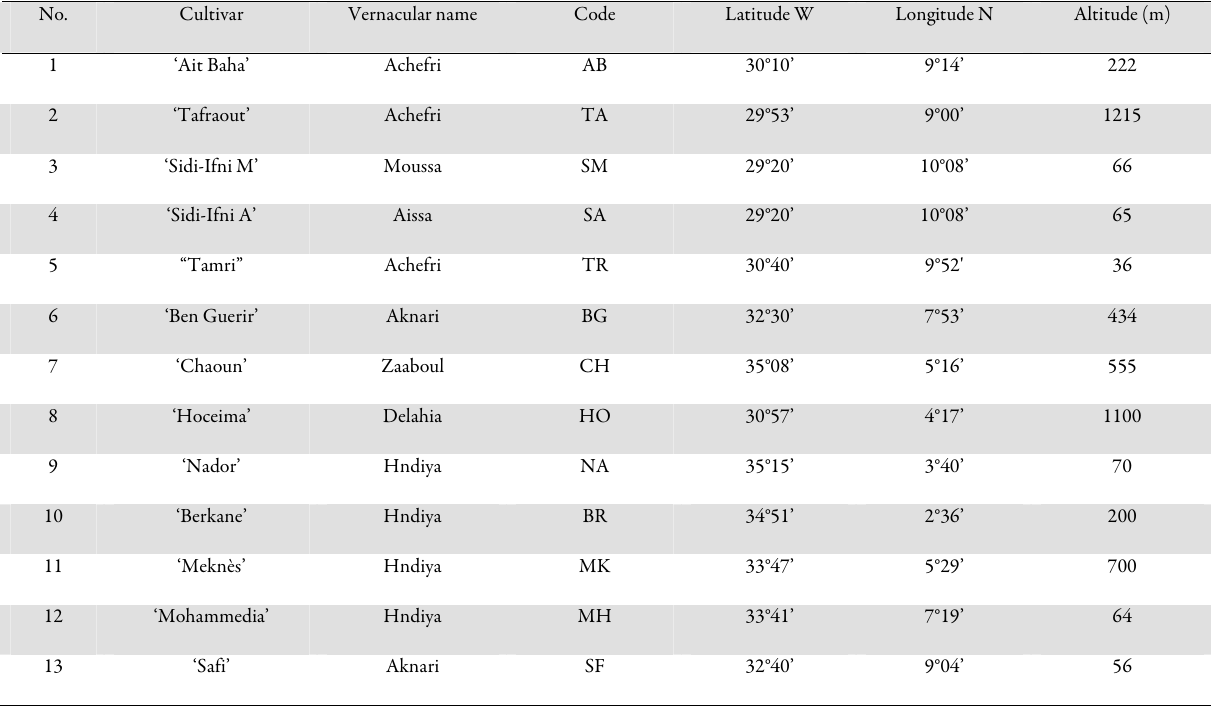
Table 1. Opuntia ficus-indica cultivars with their main area of origin in